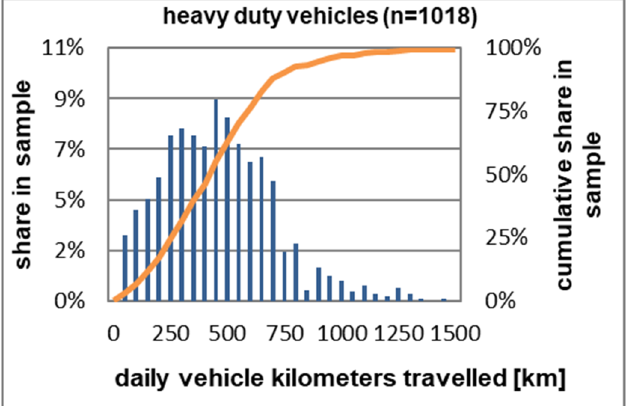
Figure 1. Daily vehicles kilometers travelled by heavy-duty vehicles (semitrailer trucks) in Germany. Data from [4].